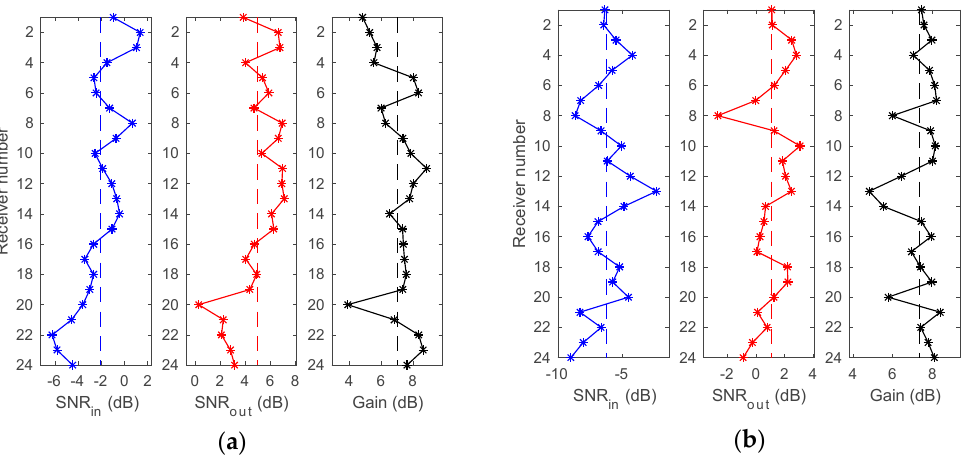
Figure 4. Performance of single element TR processing: input SNR, output SNR and temporal focusing gain. ( a ) 50 km UWA communication; ( b ) 80 km UWA